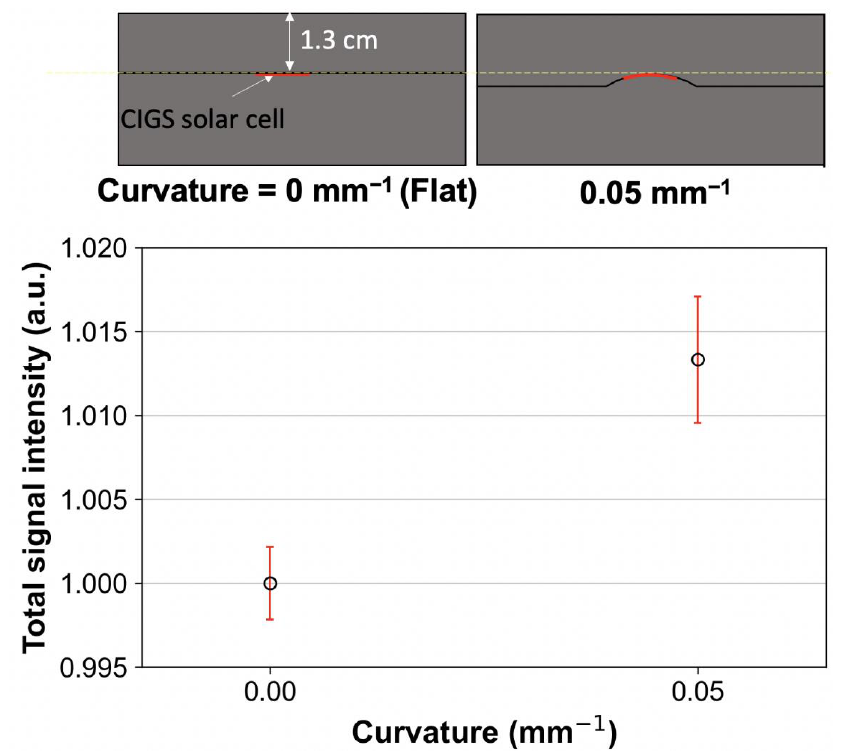
Figure 8. The copper indium gallium selenide (CIGS) solar cell signals under flat and bent condi- tions, respectively, in 6 MV photon beams. Zero curvature means a flat condition. The normalization was performed based on the signal corresponding to the flat CIGS solar cell. Error bars denote the standard deviations between three repeated measurements.